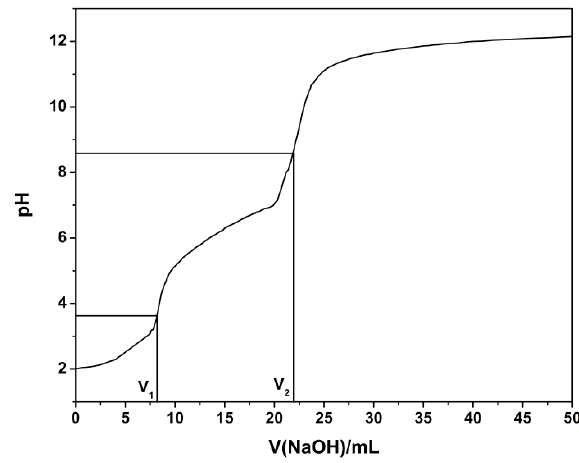
Figure 3. Potentiometric titration curve of O -CMCS.